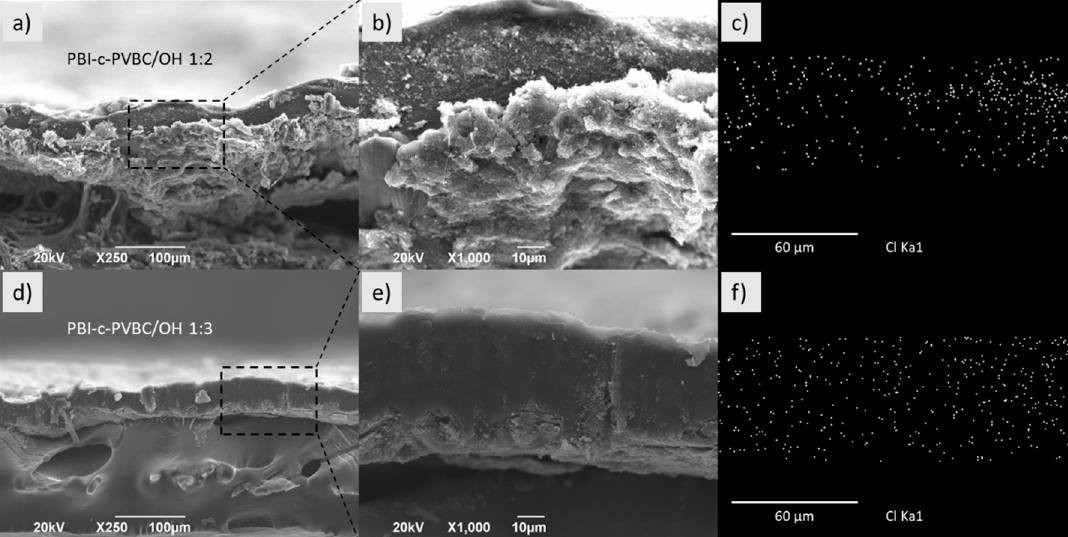
Figure 5. Cross-section ( a , d ) SEM micrographs; ( b , e ) detailed inset and ( c , f ) corresponding Cl EDX mapping of PBI-c-PVBC/OH 1:2 and 1:3 membranes, respectively.